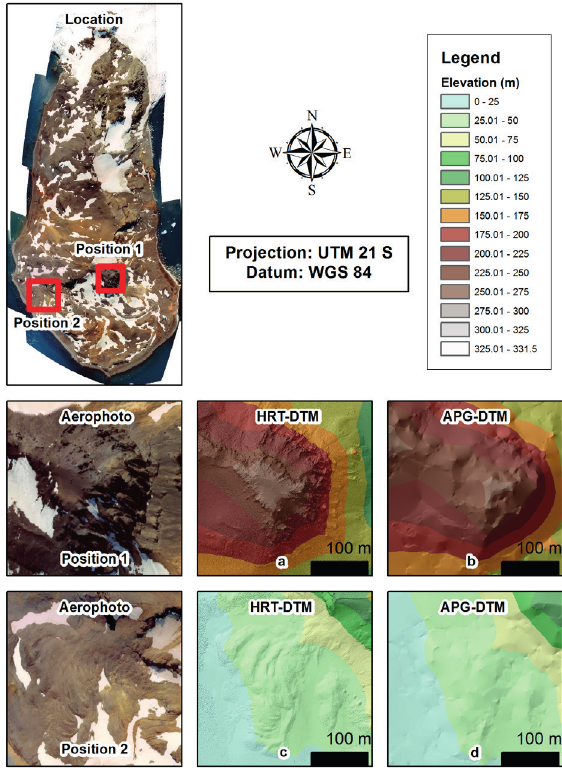
Figure 9 - Illustrative representation of the DTM generated by HRT-DTM (a and c) and the APG-DTM (b and d) methods, in two different positions (Aerophotos adapted from Francelino M.R., unpublished